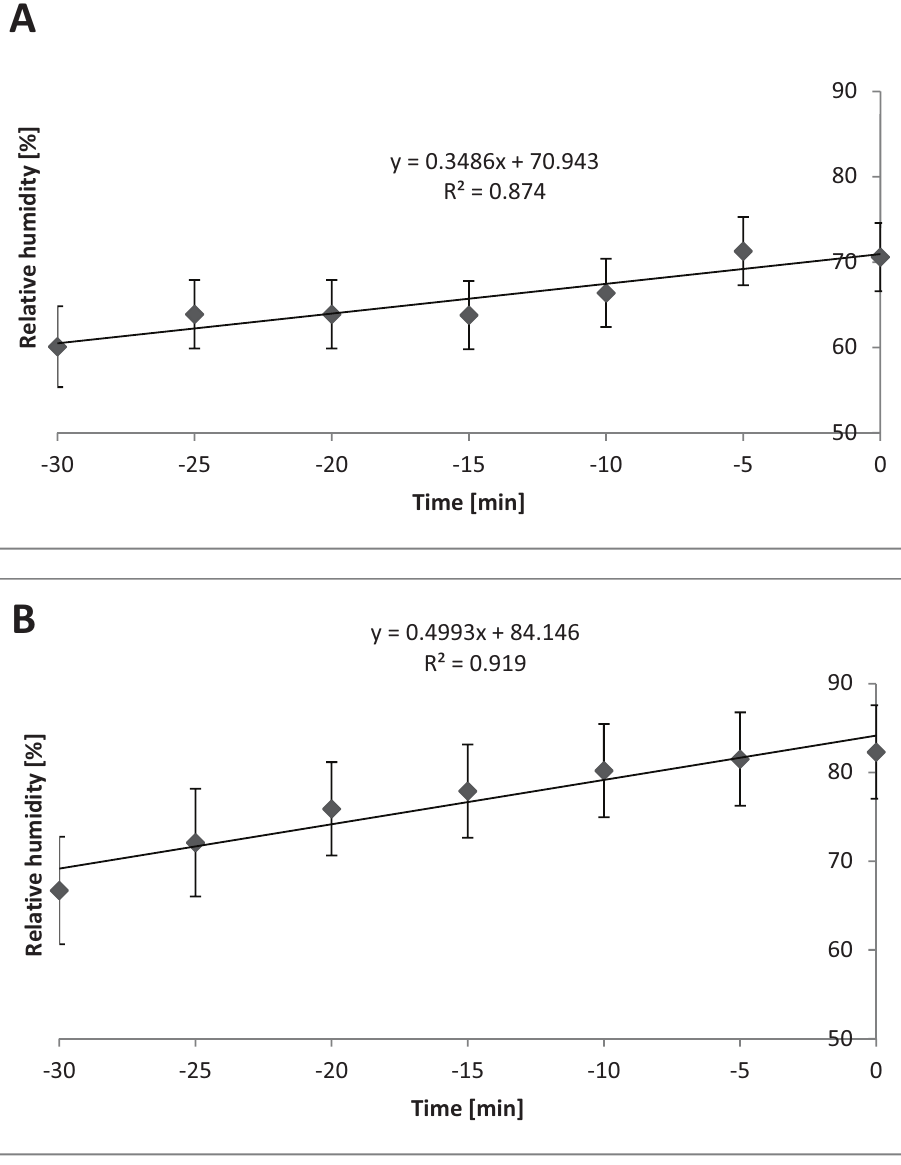
y = 0.3486x + 70.943 R² =